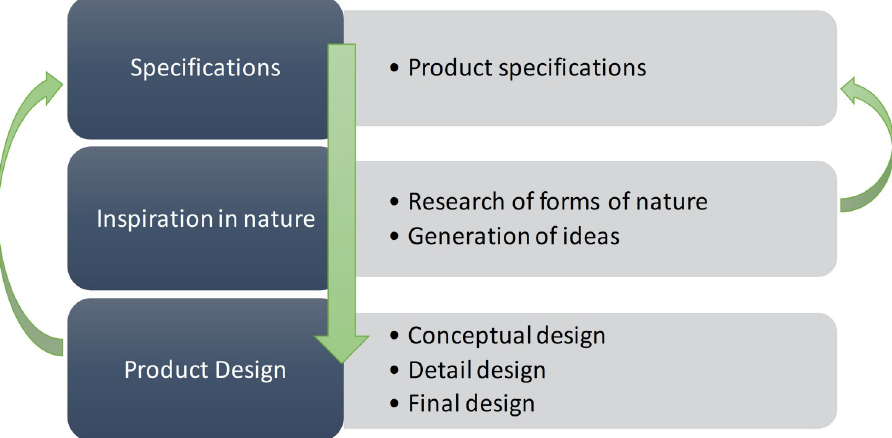
Fig 1. Flowchart of the design